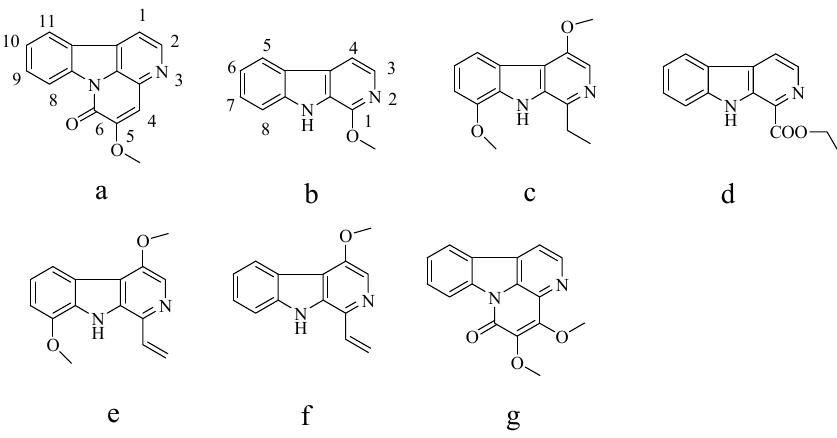
Figure 2. Chemical structures of alkaloids from Picrasma quassioides